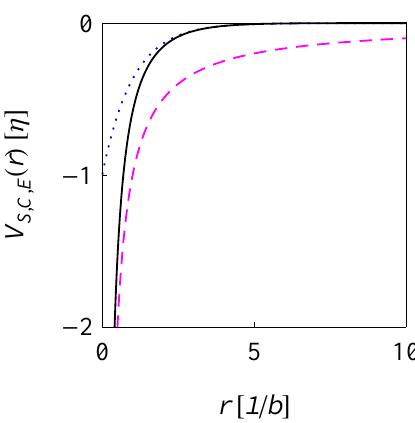
Figure 1. Hulthén potential V S ( r ) (solid black line), Eq. (18), and asymptotes (19): negative exponential potential V E ( r ) (dotted blue line) and Coulomb potential V C ( r ) (dashed magenta line), for strength η =